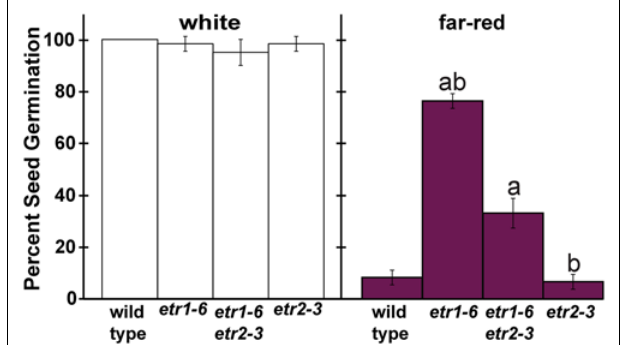
FIGURE 1 | Ethylene receptors affect germination in response to different wavelengths of light. Seed germination of wild-type seeds was compared to ethylene receptor loss-of-function mutants. Seeds were treated with 4 h of white light, followed by 3 h of different colors of monochromatic light or white light as indicated. For dark controls, seeds were treated for 5 min with far-red light immediately after sowing without a pre-treatment with white light.The seeds were then placed in darkness for 7 days. At that time seed germination was measured and the percent of seed germination calculated. Plots show the average ± SD from at least three biological replicates. ND denotes no germination detected. Data were analyzed by t -tests and differences considered statistically significant with P < 0.05. a Significant difference from white light for that ecotype; b Significant difference of mutant from wild-type after the same light treatment.